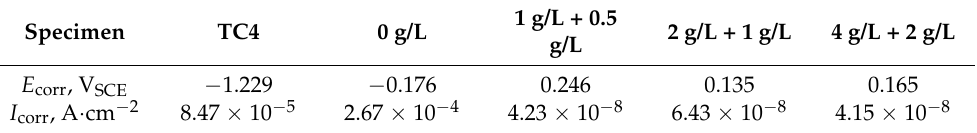
Figure 9. Potentiodynamic polarization curves of the MAO coatings with different concentration of Si 3 N 4 /TaC particles in the artificial seawater. Table 5. Potentials and current densities of both the TC4 alloy and the composite MAO coatings with different concentration of Si 3 N 4 /TaC